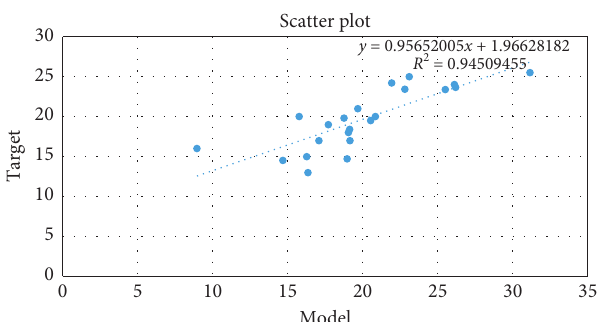
Figure 5: The test result for the best GEP function (curve fitting).